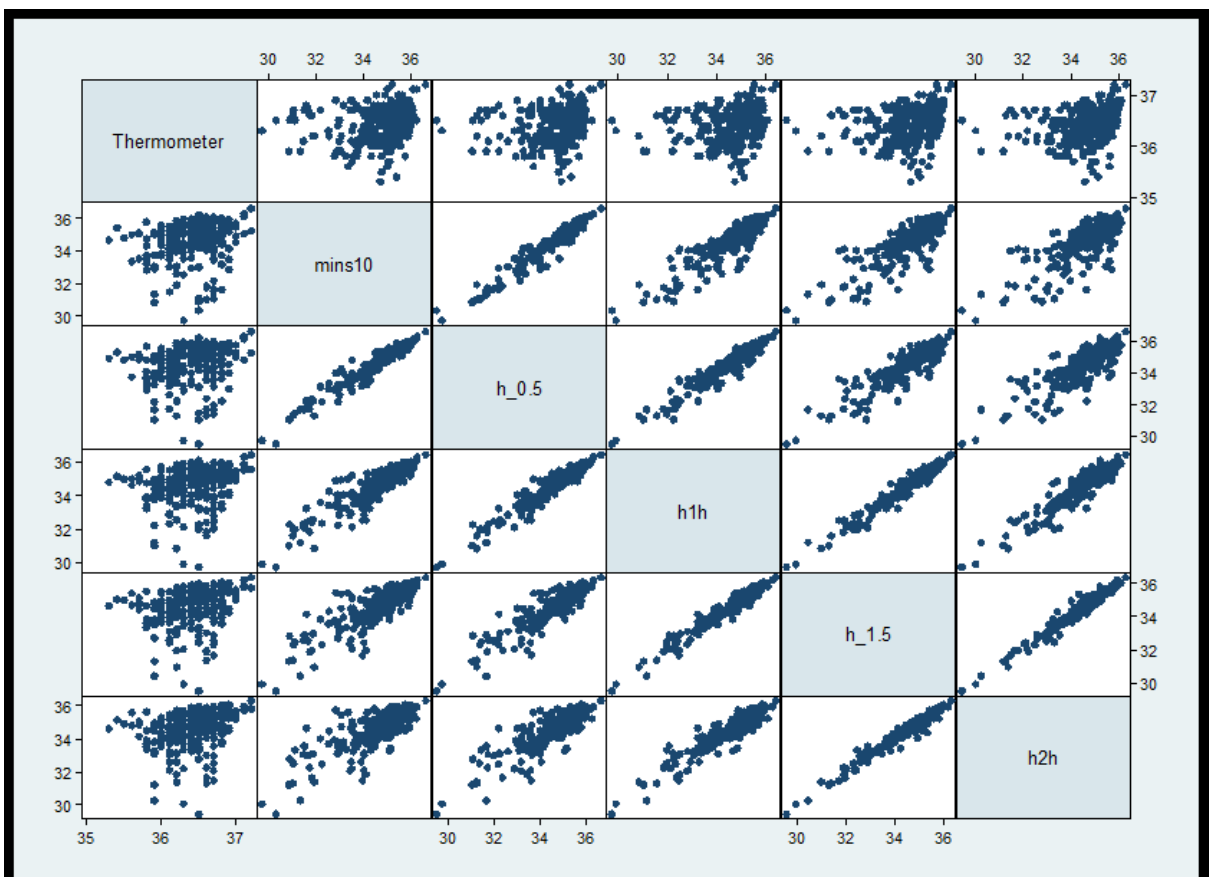
Figure 2. Correlations between thermometer and different time points performed to determine correlation between temperatures recorded by BMSW 10, 30, 60, 90, and 120 minutes before waking and the digital oral thermometer, as well as correlation between temperatures recorded at each of the 5 time